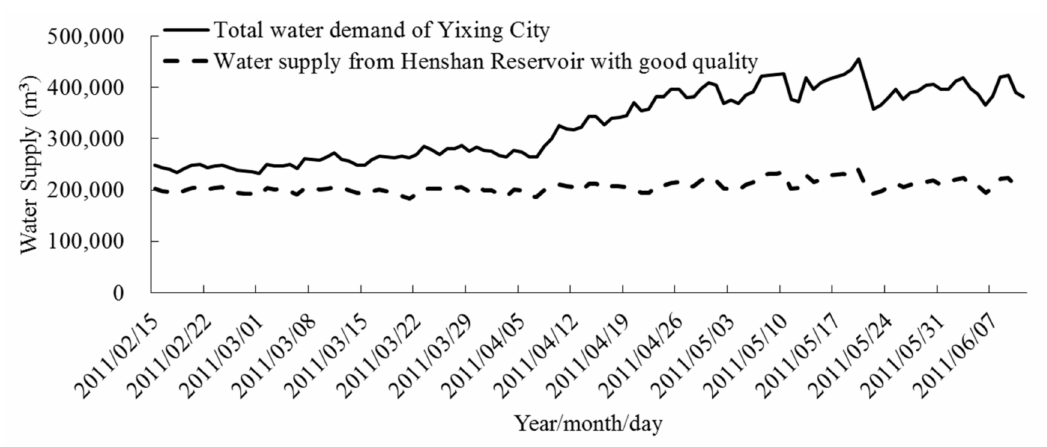
Figure 9. Water demand in Yixing City in